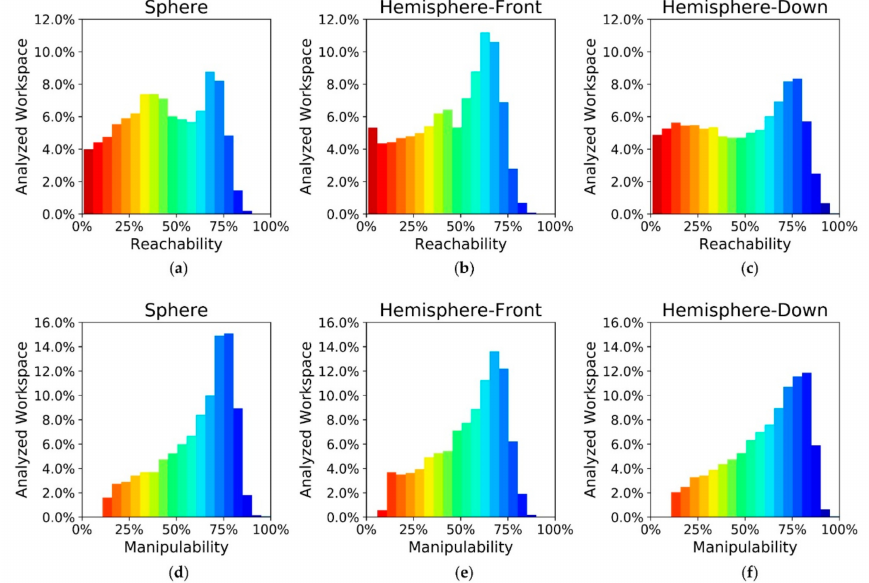
Figure 22. Workspace evaluation of the mobile manipulator OMNIVIL. ( a ) Reachability (spherical); ( b ) reachability (hemispherical-front); ( c ) reachability (hemispherical-down); ( d ) manipulability